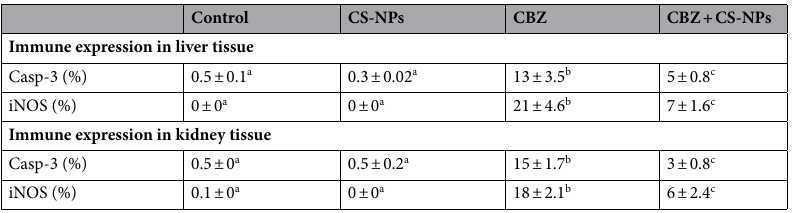
Table 6. Mean percentage area of different immune markers expression in liver and kidneys. Values represented as Mean ± SEM (n = 7 microscopic field in 5 sections representing 5 rats/group). Values with different letters at the same row means significant difference at P ≤ 0.05.